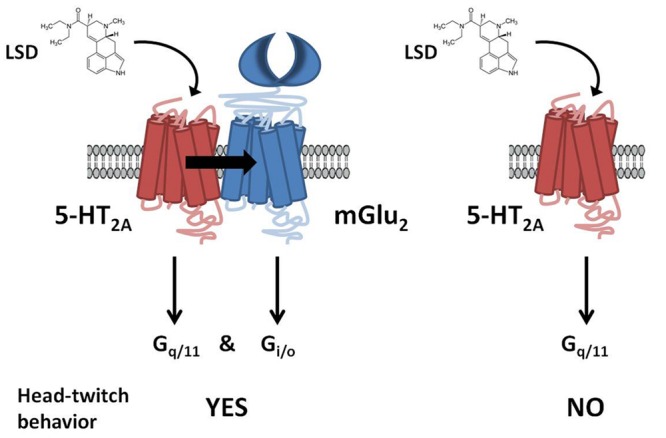
G protein-dependent signaling and behavioral responses that require the 5-HT2AR/mGlu2R heterocomplex. LSD acting at the 5-HT2AR/mGlu2R heterocomplex activates both Gq/11- and Gi/o-dependent signaling. In contrast, when 5-HT2AR and mGlu2R are prevented from forming a receptor heterocomplex, activation of 5-HT2AR by LSD elicits characteristic signaling of Gq/11-protein subtypes. Head-twitch behavior is reliably and robustly elicited by hallucinogenic 5-HT2AR agonists, and is absent in mGlu2R-KO mice. Adapted from Gonzalez-Maeso (2011).